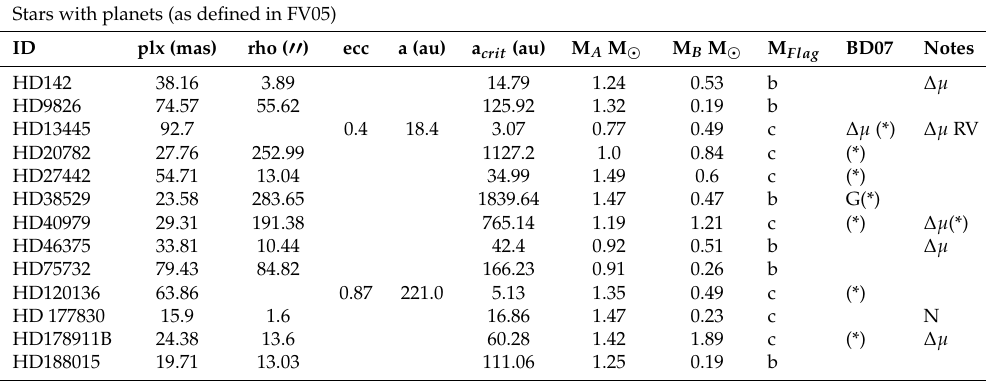
Table A1. Properties of binaries found in the UD sample. The new companions are marked with N .